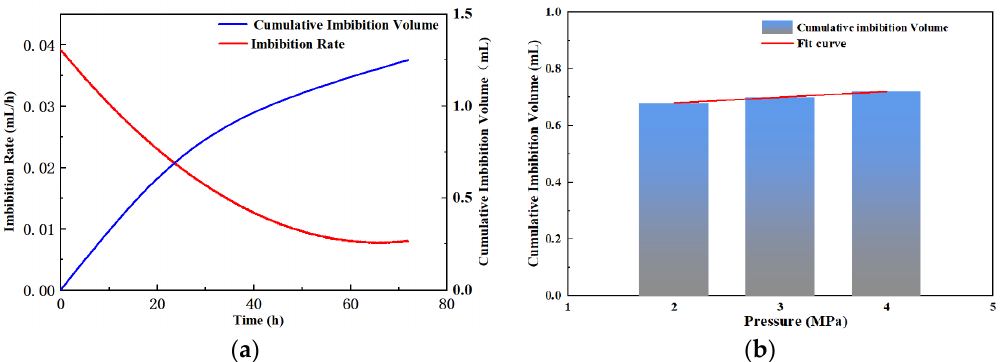
Figure 4. Water imbibition during shale hydration: ( a ) the relationship between cumulative water imbibition and hydration time: the hydration pressure was 3 MPa, and the water imbibition increased with time ( b ) the relationship between cumulative water imbibition and hydration pressure: when the hydration time was set 24 h, the water imbibition was close under different hydration pressure.